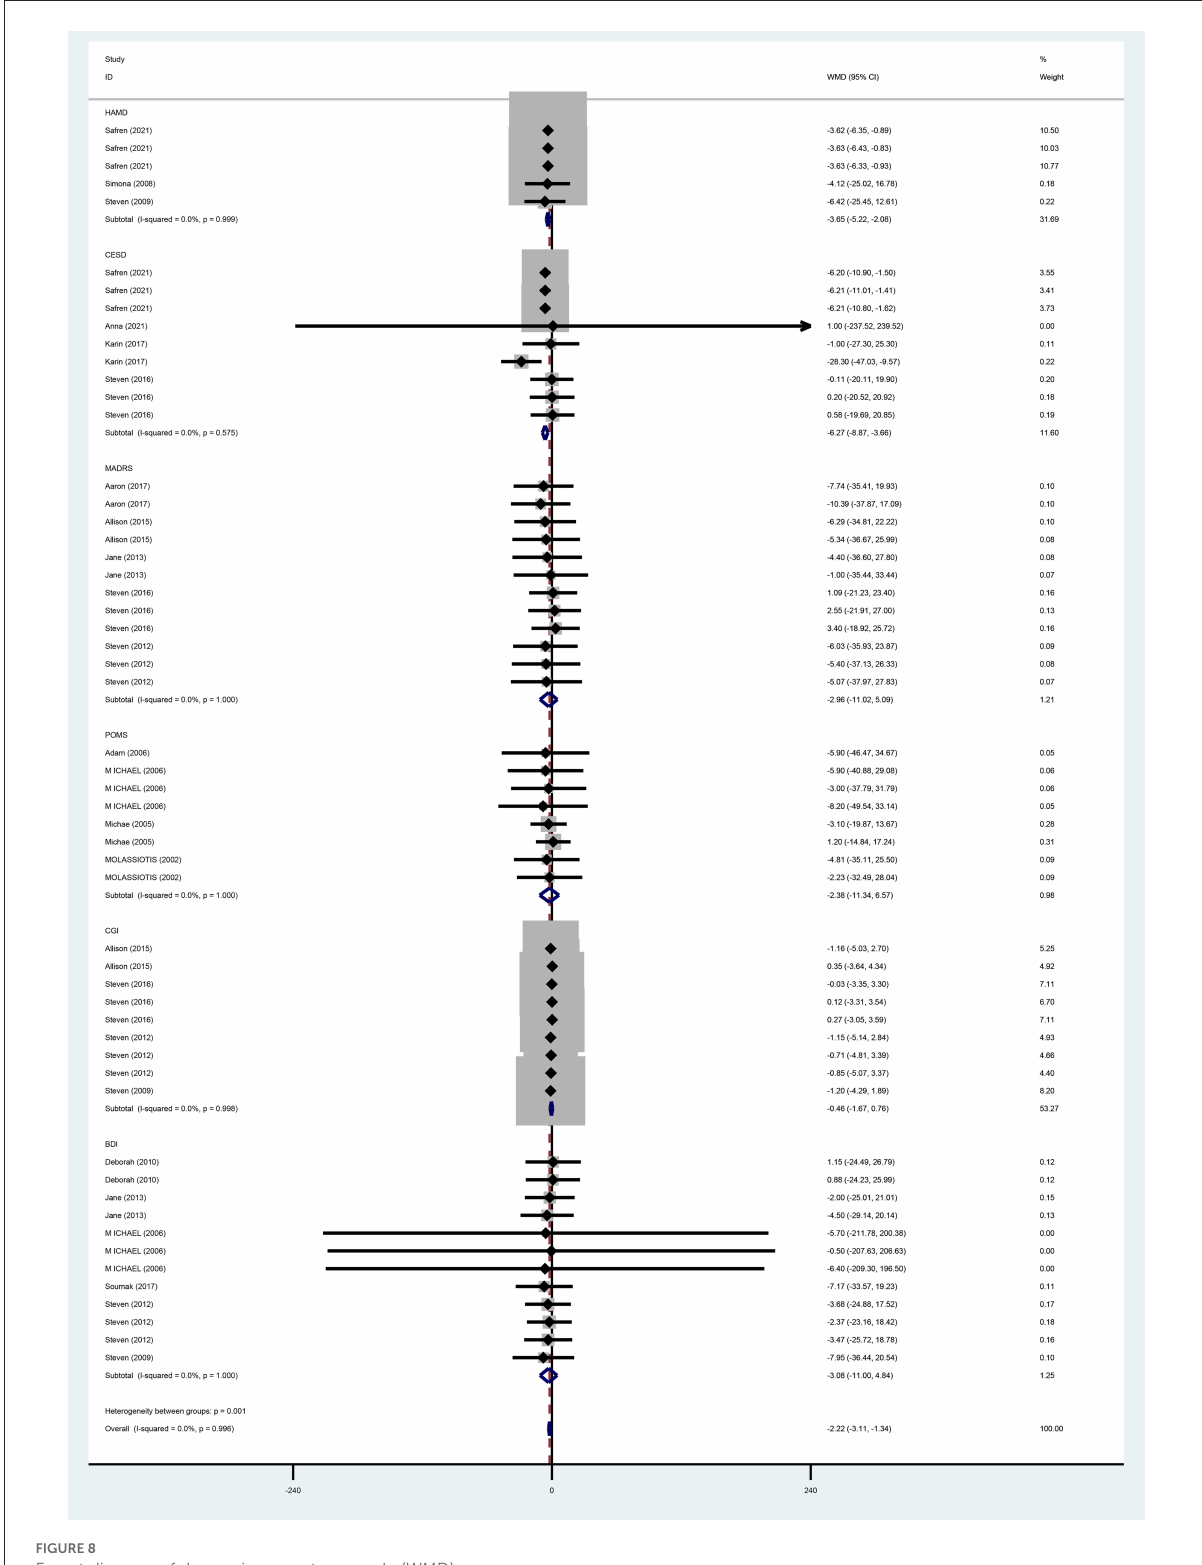
FIGURE8 Forest diagram of depressive symptoms scale